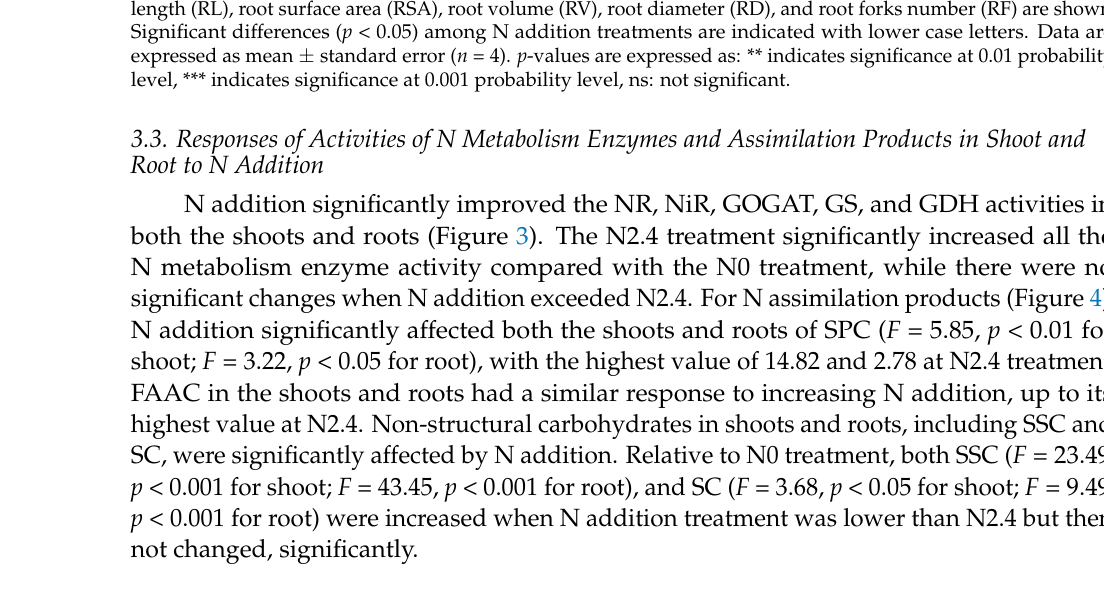
Table 1. Results of one-way ANOVA for the effects of N addition on soil properties and A. mongol- icum root morphological traits.